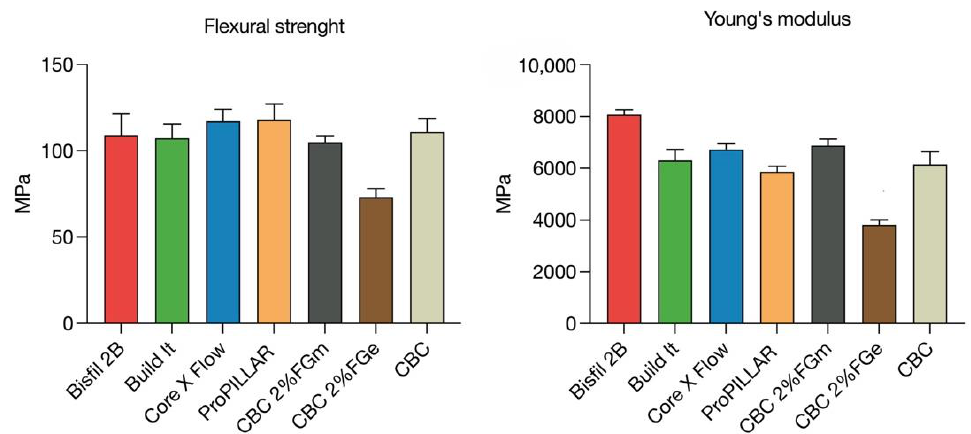
Figure 4. Graphical analysis of values reached by tested materials in flexural strength tests.